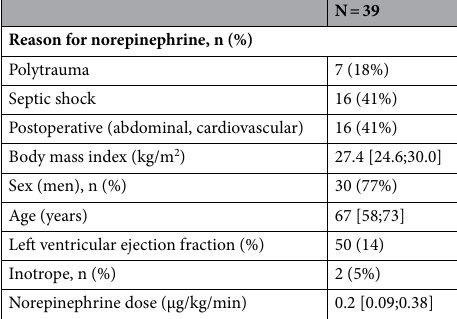
Table 1. Baseline characteristics.